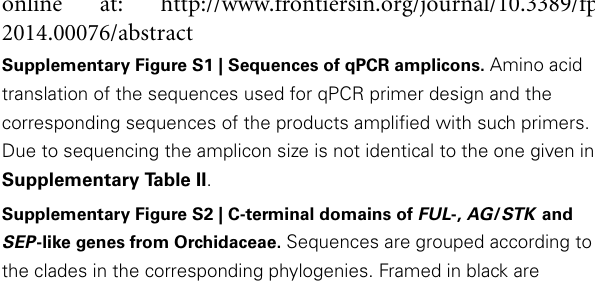
Supplementary Figure S2 | C-terminal domains of FUL -, AG / STK and SEP -like genes from Orchidaceae. Sequences are grouped according